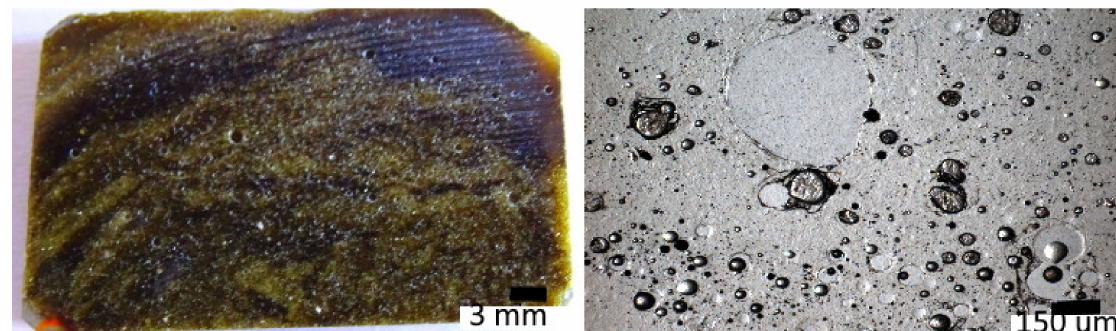
Figure 19. A macrograph and an optical micrograph of a section of Muong Nong tektite from Laos (Laos-1